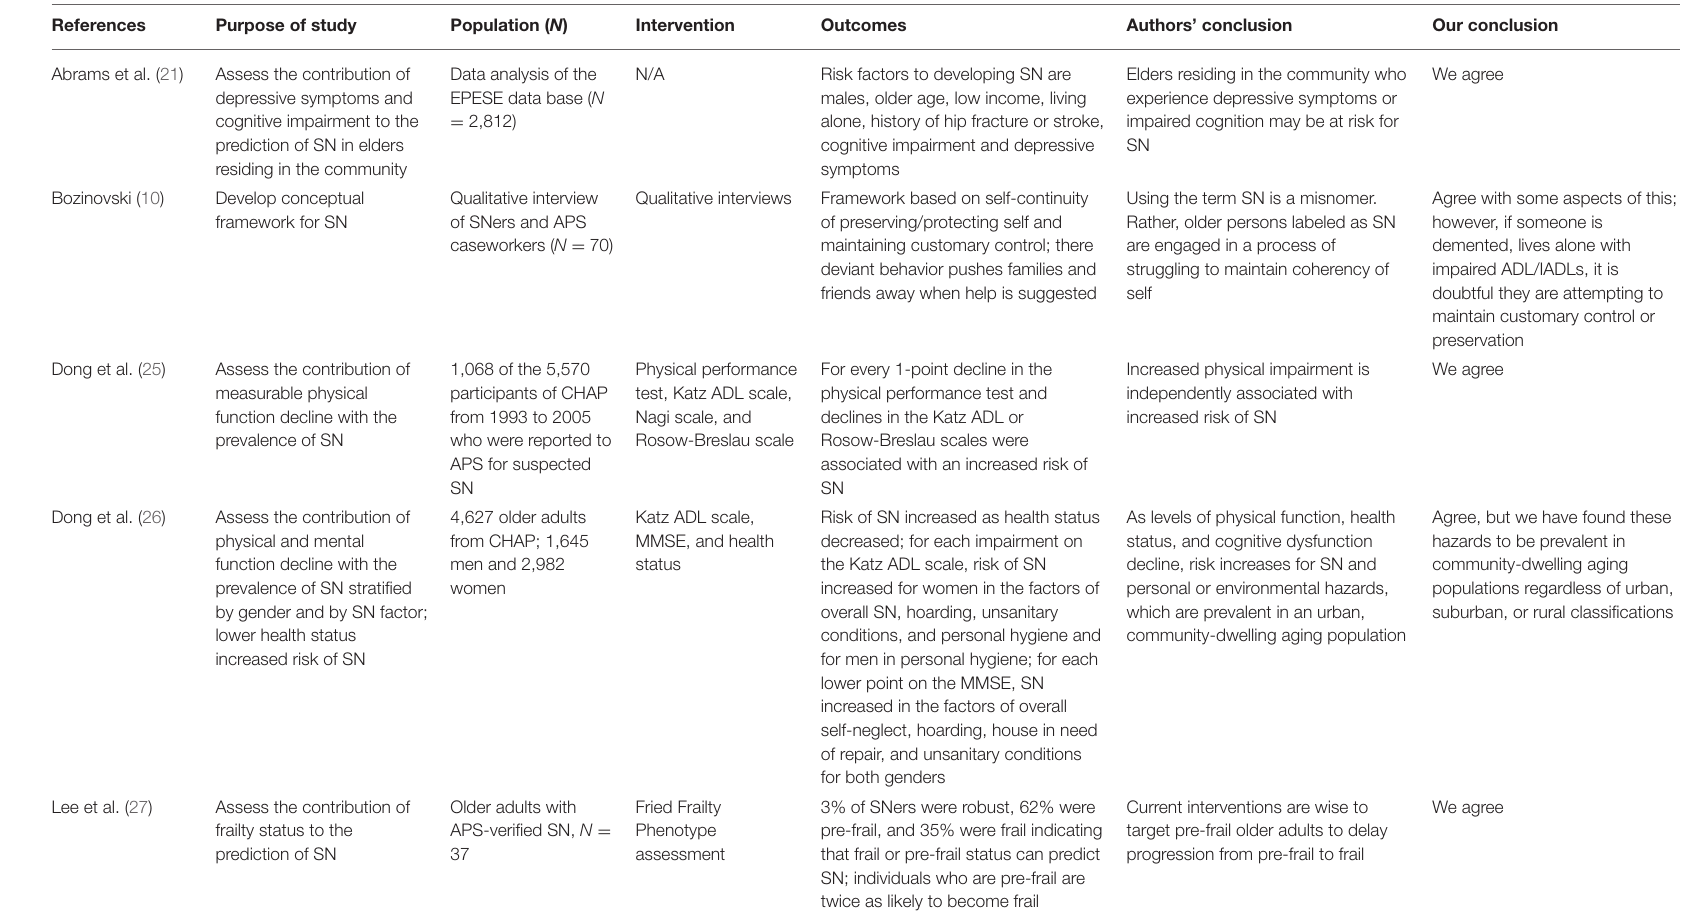
TABLE 3 | Known predictors increases